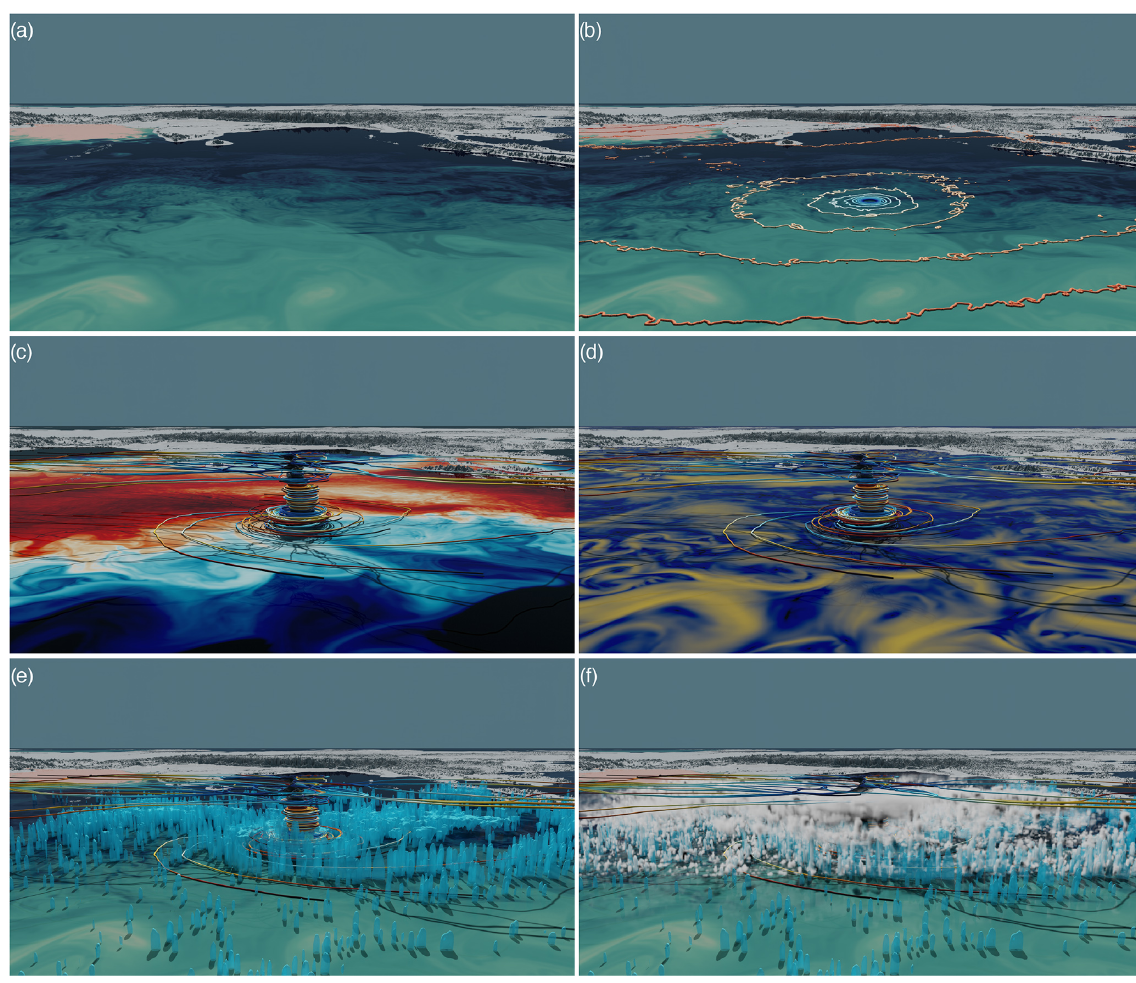
Figure 12. A low-pressure system in the Southern Ocean and associated large- and small-scale features, visualized from G_AO_2.5km with (a) salinity, (b) salinity (shading) and sea level pressure (contour lines), (c) wind (streamlines) and surface temperature (shading), (d) wind (streamlines) and ocean velocity (shading), (e) wind (streamlines) and rain (blue shading), and (f) wind (streamline), rain (blue), and cloud (white). The field of view is towards the Bay of Bengal. The tip of India and Sri Lanka can be